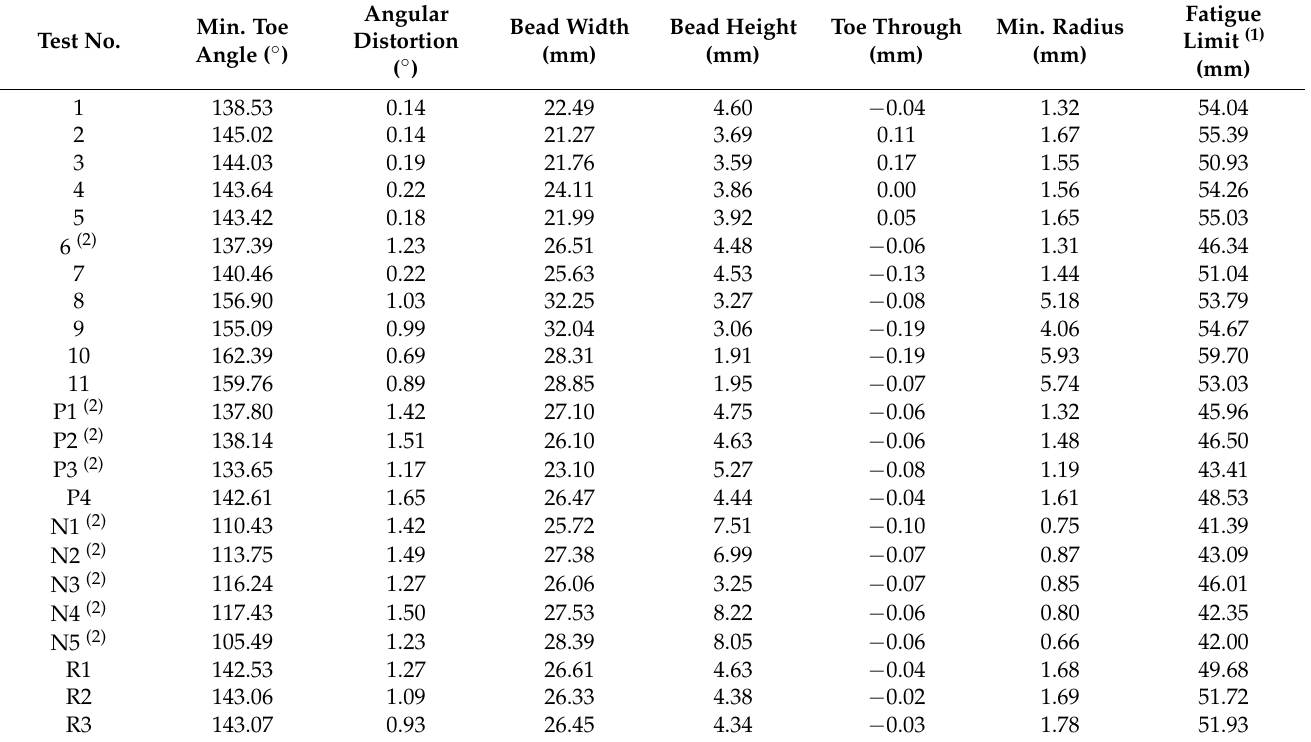
Table 6. Summary of the measured weld profiles and fatigue limit for each test number.